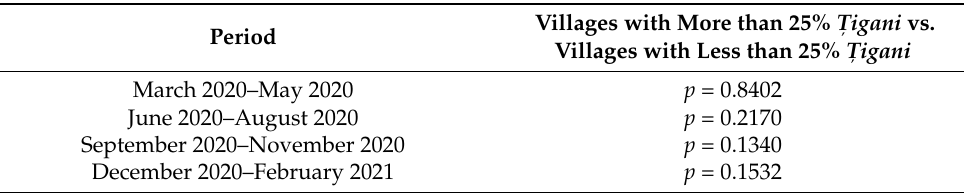
Table 3. Identifying statistical significance of SAR-COV2 infestation in Mures igani vs. villages with less T with more T ,